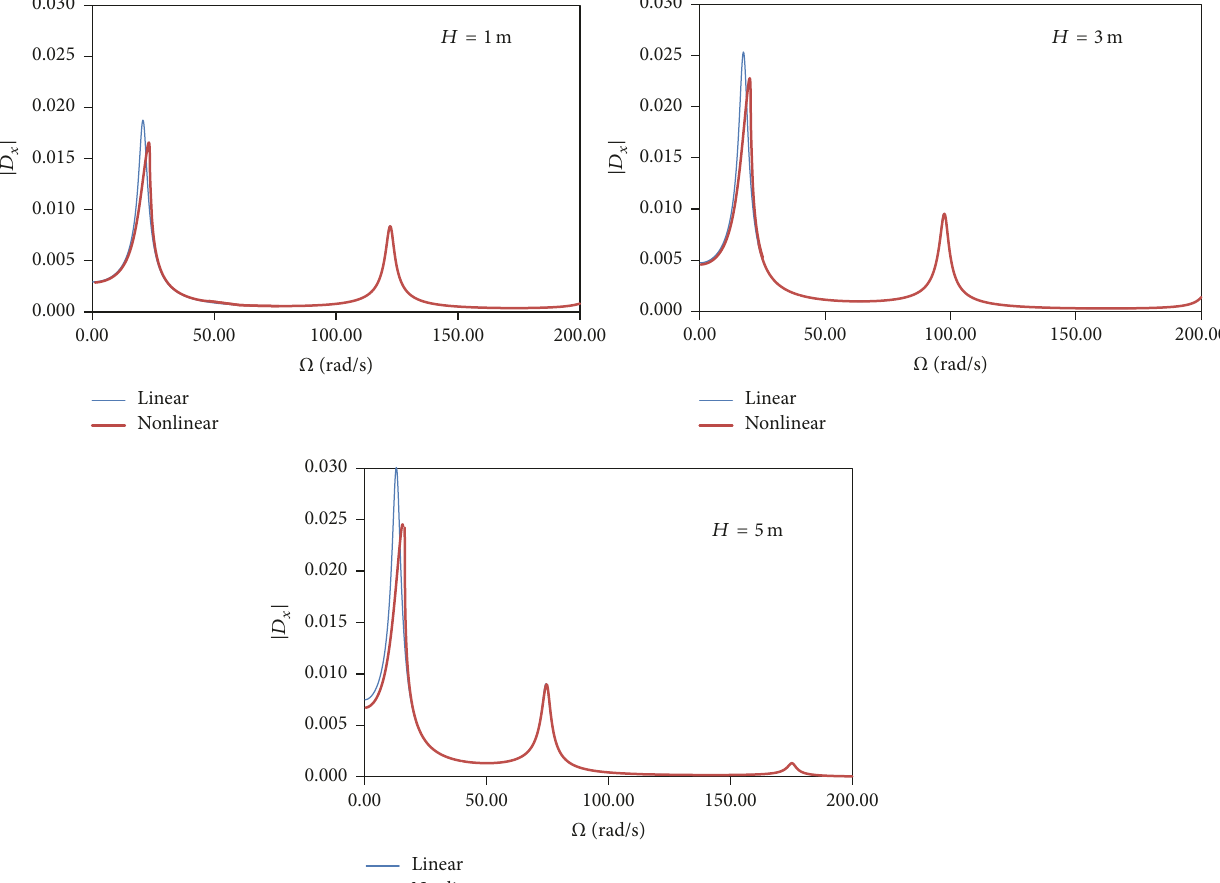
of vertical displacement 𝐷 𝑦 is reduced in the two first resonance regions with the increase of the roof height. These nonlinear resonance curves exhibit amplitude and frequency limit points. This indicates the existence of fold (saddle- node) bifurcations, which can only be mapped by the use